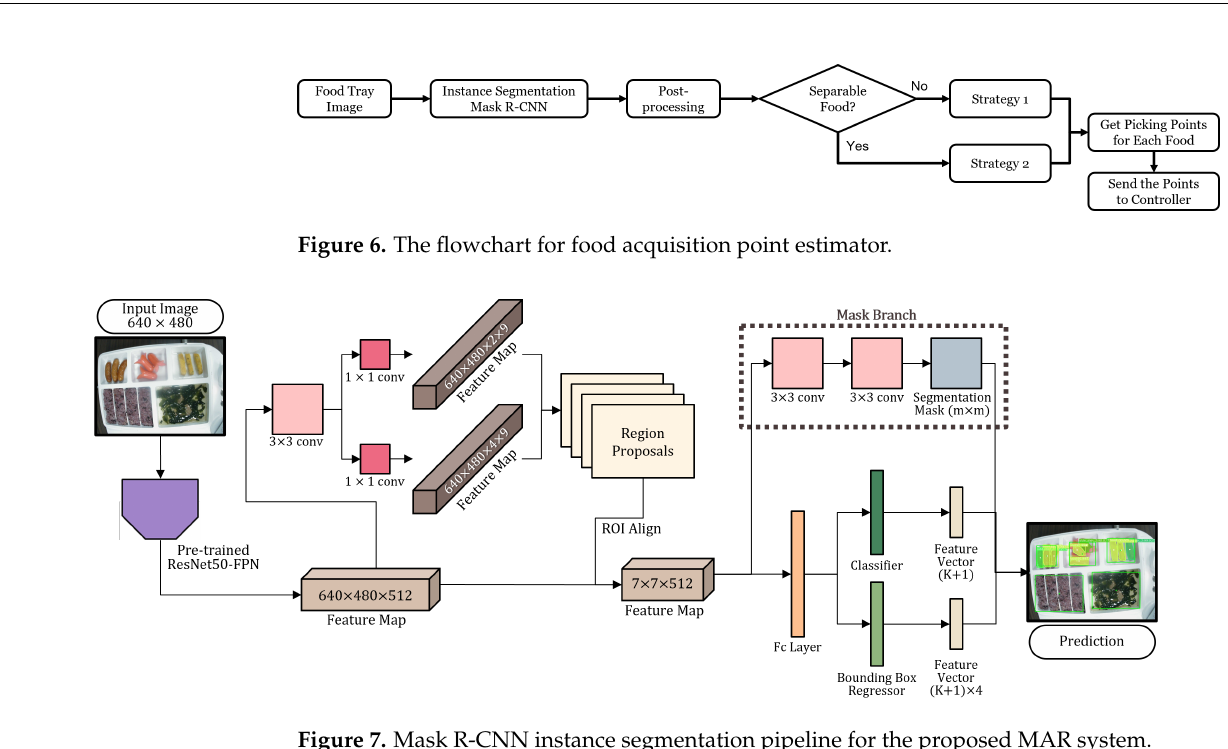
Figure 7. Mask R-CNN instance segmentation pipeline for the proposed MAR system.